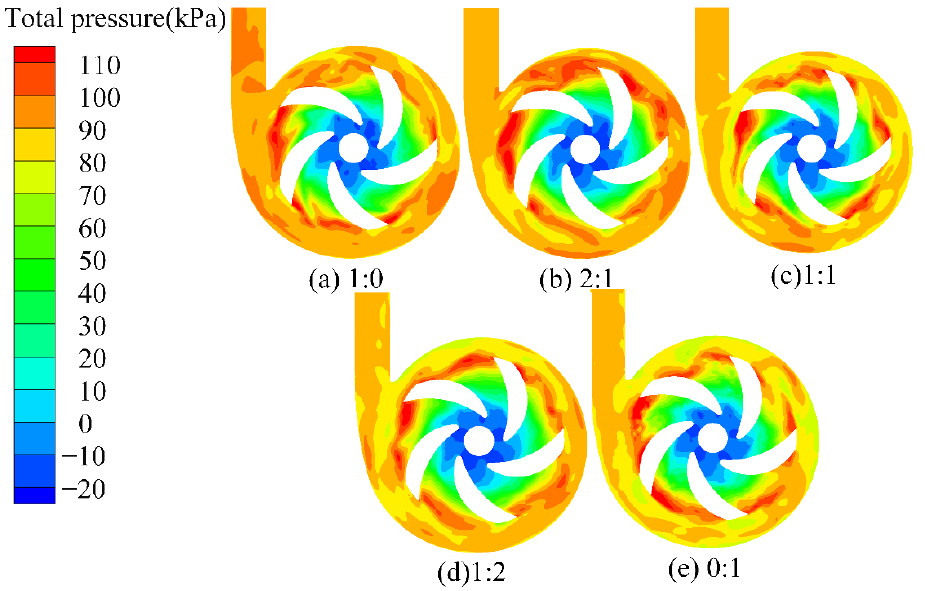
Figure 9. Total pressure distribution of centrifugal pump with different particle ratios.